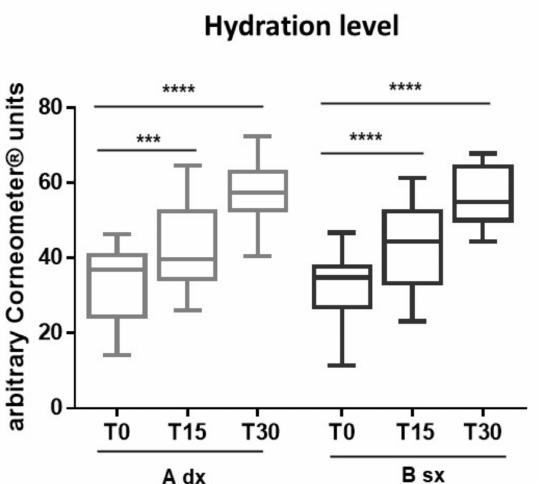
Figure 8. Variation of hydration values before treatments (T 0 ) and after 30 days (T 30 ) of application of A and B. Results as mean ± SD of three determinations for each volunteer at different measurement times. Data were analyzed by two-way RM (repeated measures) ANOVA (analysis of variance), followed by a Bonferroni adjustment. Data were significant different p value < 0.05 ( p < 0.001 ***; p < 0.0001